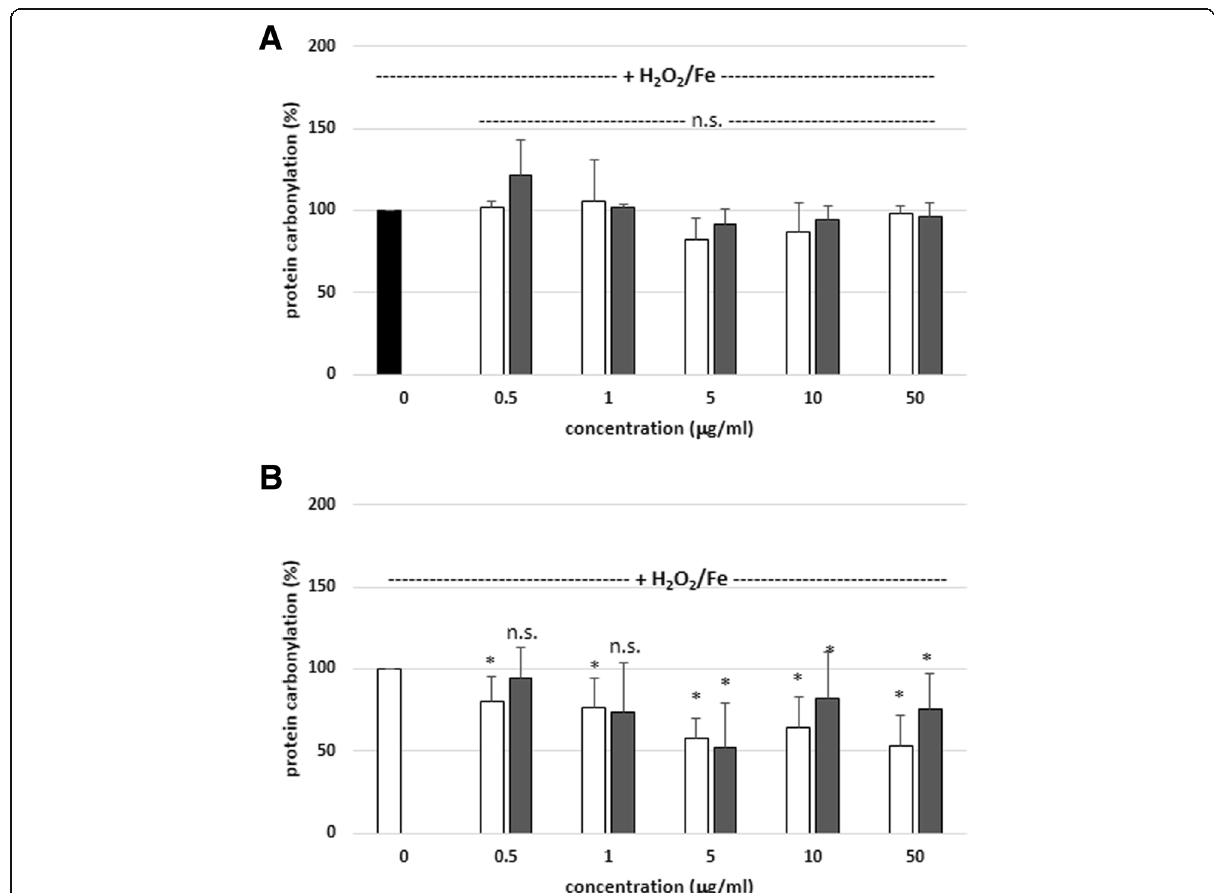
Fig. 4 Effects of SBT twig and leaf extracts (0.5 – 50 μ g/mL; 15 min ( a ) and 60 min ( b )) on plasma protein carbonylation induced by H 2 O 2 /Fe. In these experiments the carbonyl group level (marker of protein oxidation) in control samples (plasma treated only with H 2 O 2 /Fe) was 30.4 ± 5.1 nmol/mg of plasma protein. Data represent means ± SD of 6 – 12. The effect of five different concentrations of two tested extracts (0.5, 1, 5,